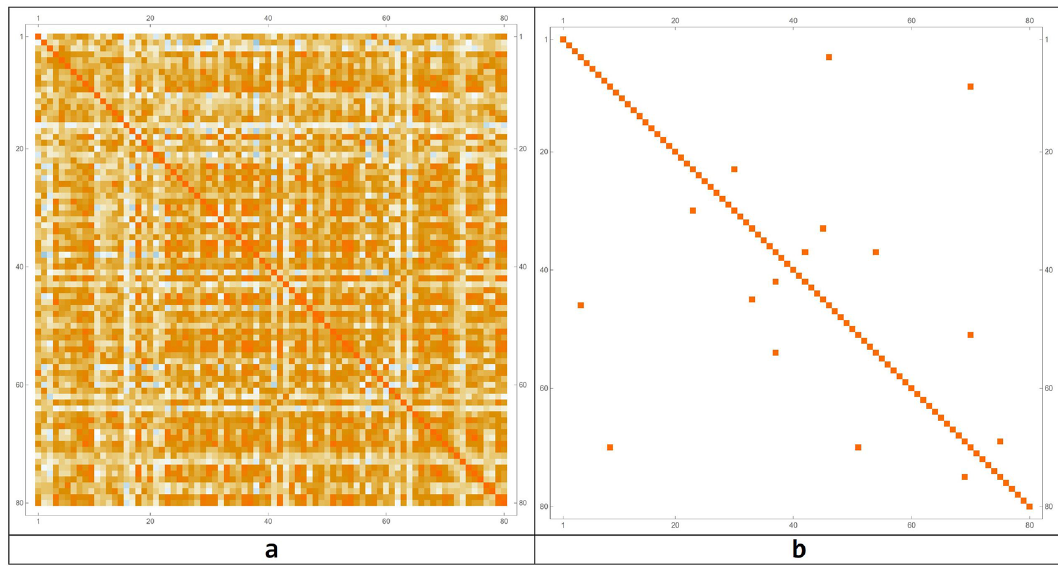
Figure 7. Correlation matrix among all the nodes that change over time ( a ) and with a threshold ( b ). In this case, the threshold level has been set to 0.87. Connectome nodes Brodmann